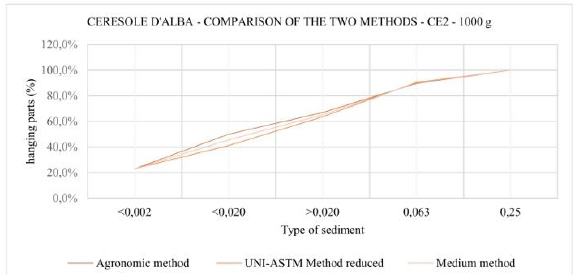
Figure 7. Selected soils grain size distribution – Comparison method, reworking of the authors.